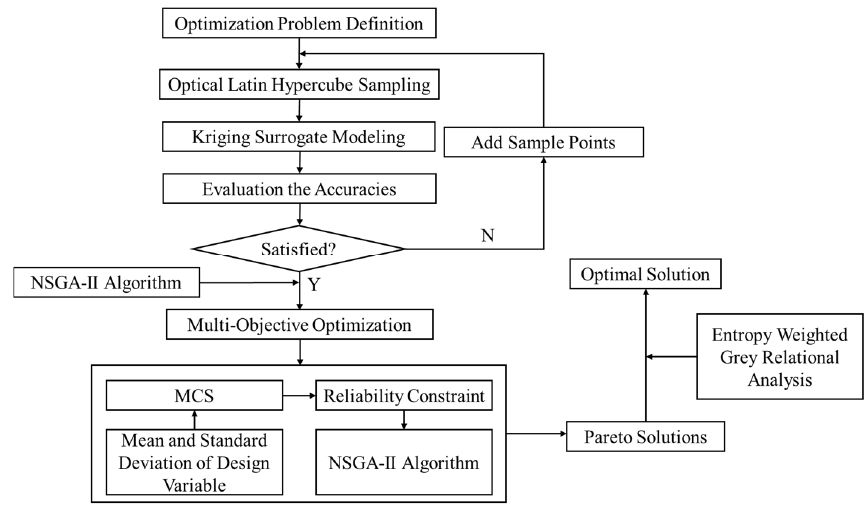
Figure 3. Flowchart of the proposed multi-objective reliability optimization method.